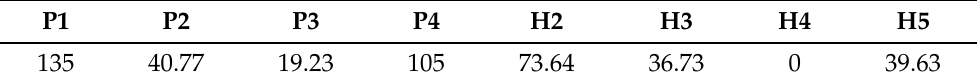
Table 6. Optimal schedule for the best cost obtained for Case study